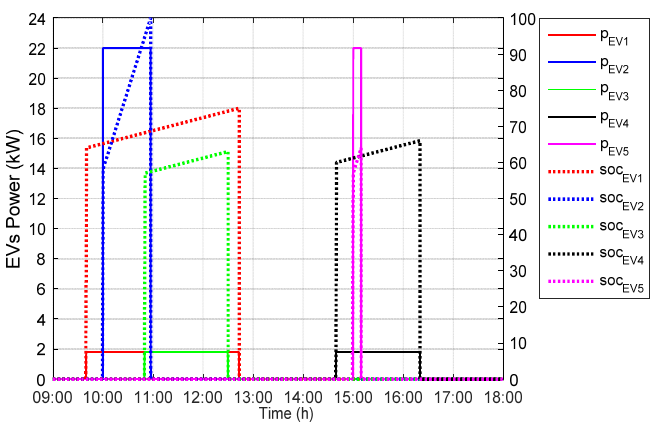
Figure 24. EVs charging power and EVs SOC evolution for Scenario 2e.